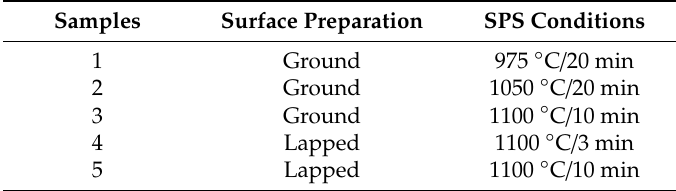
Figure 8. Interface between two joined disks where ( a ) shows the associated electron backscatter diffraction (EBSD) image, ( b ) reveals the pole figures of the large millimetric grains, and ( c ) represents the pole figures of the small micron-size grains at the interface. The same colour code is used in (a), (b), and (c). Table 2. Summary of the SPS-joining